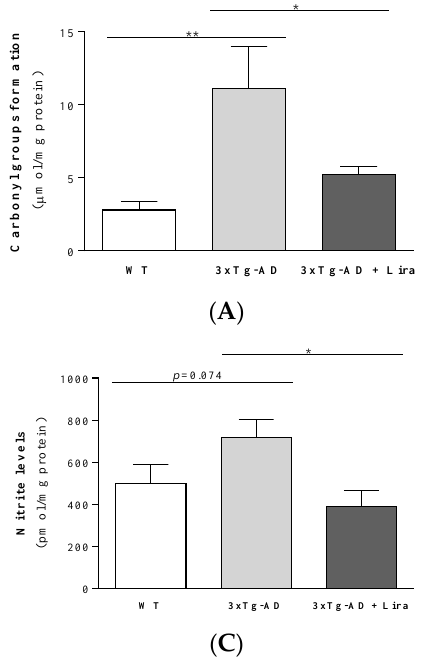
Figure 6. Effect of liraglutide on brain cortical oxidative and nitrosative stress markers in female mice with early AD-like pathology. Brain cortical carbonyl groups formation ( A ), 8-OH-dG ( B ) and nitrites levels ( C ) were determined. Data are the mean ± SE from 5–7 mice/group. Statistical significance: * p < 0.05 or ** p < 0.01, by the one-way ANOVA with the Fisher LSD post-hoc test for multiple comparisons.